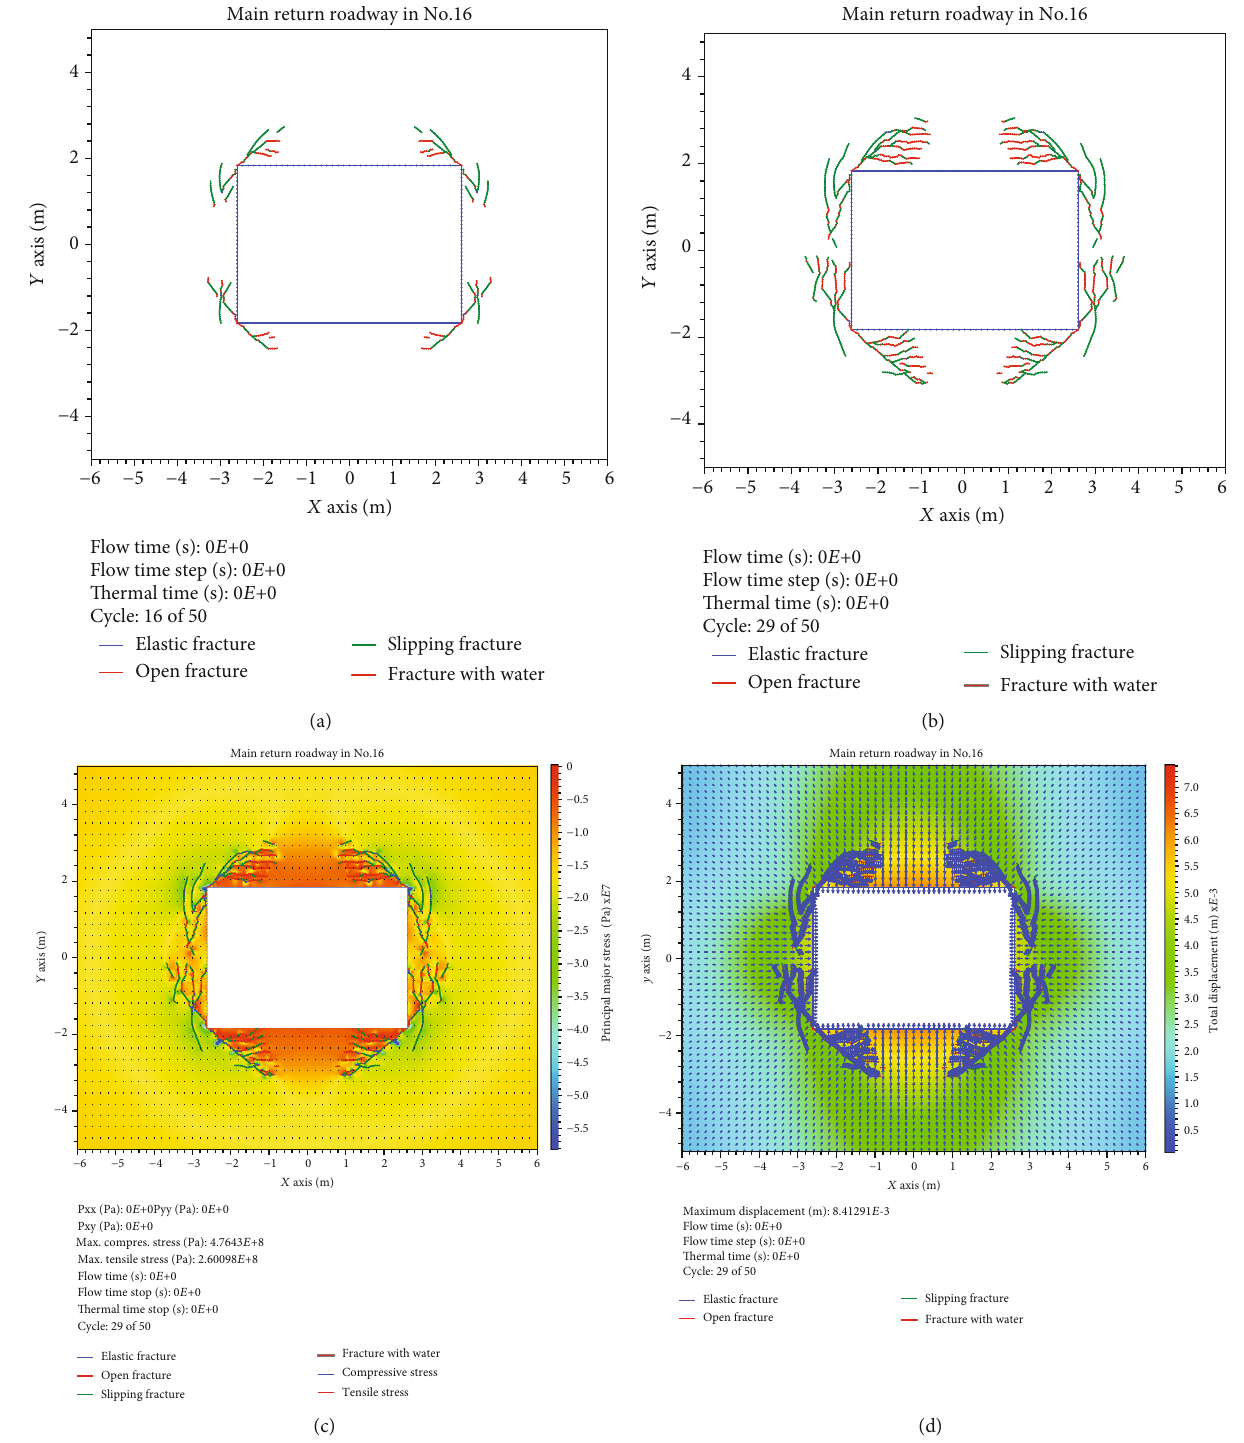
Figure 8: Veri fi cation model for the main return roadway in the No. 16 coal seam. (a) Fracture initiation in rock surrounding the roadway at cycle 16. (b) Fracture propagation and coalescence in rock surrounding the roadway at cycle 29. (c) The distribution of major principal stress in surrounding rock at cycle 29. (d) The distribution of total displacement at cycle 29; size and direction of the arrows carry double information on magnitude and direction of displacement